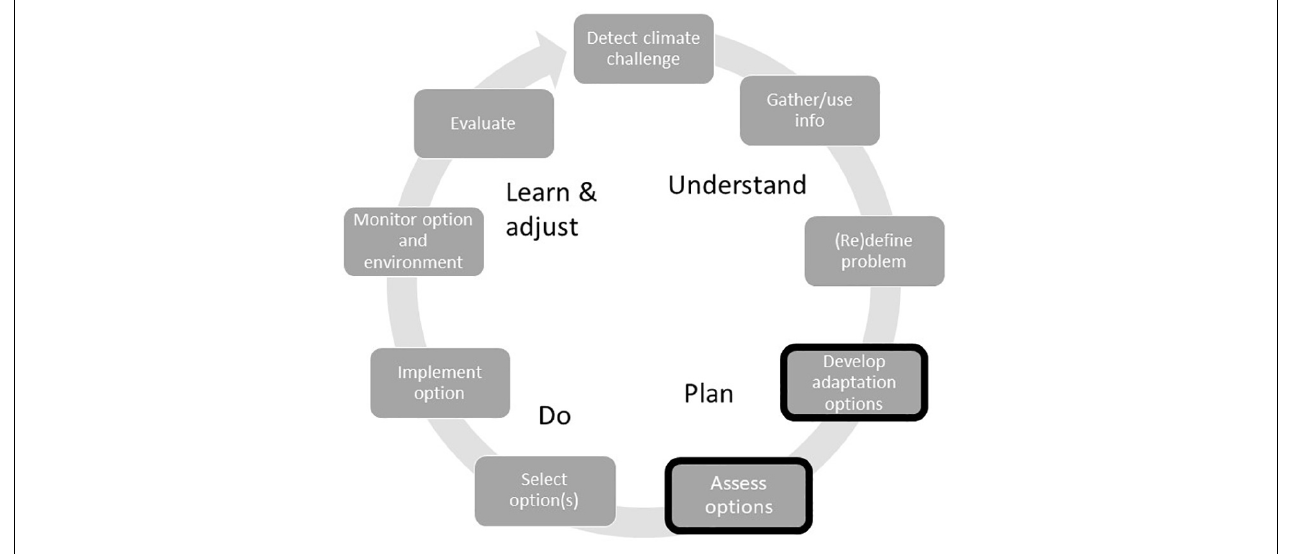
FIGURE 1 | Phases and subprocesses throughout the adaptation process [adapted from Moser and Ekstrom (2010): 22027)] as they apply to the fisheries adaptative management cycle. Highlighted boxes refer to the subprocesses the reported study